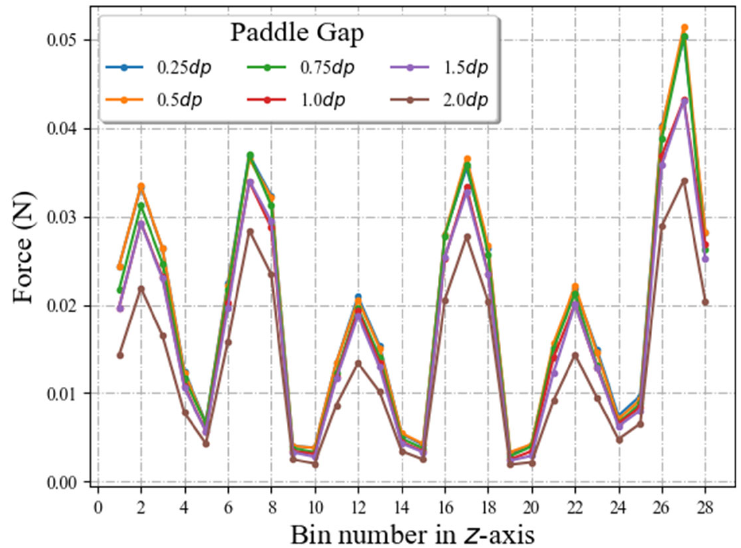
Figure 22. Time-averaged forces acting on particles in a line along z -direction for various paddle Figure 22. Time ‐ averaged forces acting on particles in a line along z ‐ direction for various paddle gaps.